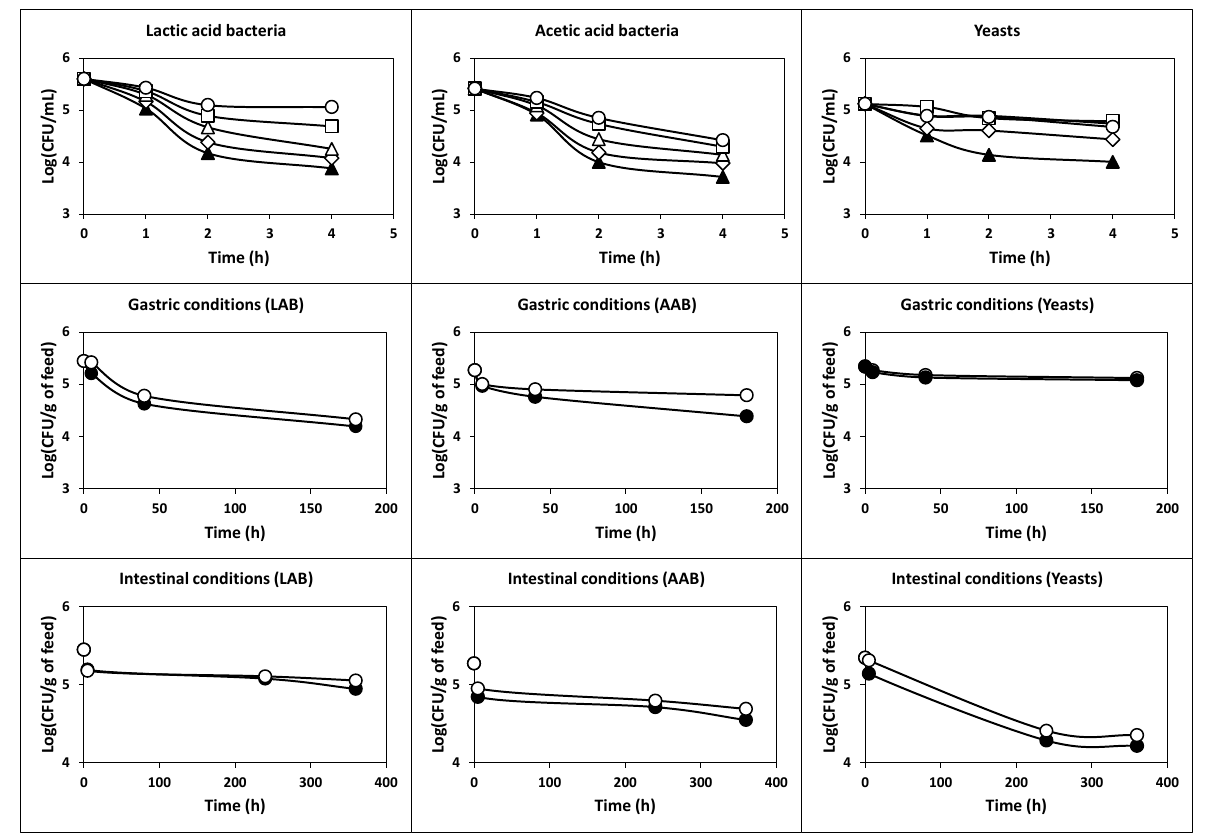
Figure 9. Survival of the populations of LAB, AAB and yeasts protected with skim milk and piglet feed at pH values 1.0 ( black triangles ), 2.0 ( diamonds ), 3.0 ( white triangles ), 4.0 ( squares ) and 5.0 ( circles ) and under simulated gastric (pH 2.0 + pepsin) and intestinal (pH 8.0 + pancreatin) transit ( black circles ). Controls ( white circles ) consisted of samples at the same pH values without enzymes. The experimental data represent the means of three experiments and two analytical replicates.